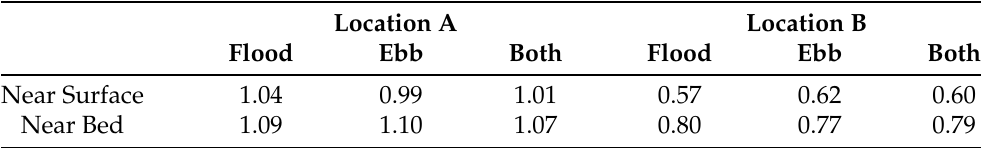
Table 4. Normalised damage equivalent load values, using the mean predicted profiles, determined using aggregate load cycles for each flow speed with constant